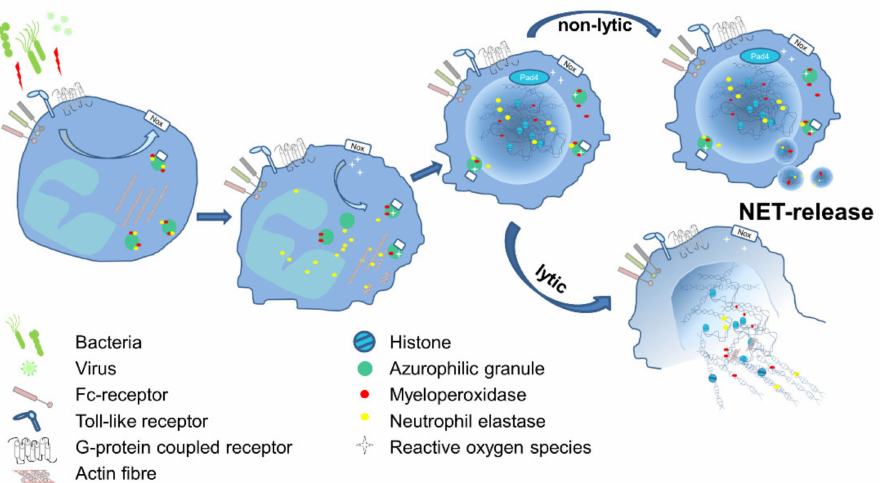
Figure 1. Schematic illustration of the essential steps of NET formation. Several pathogens are capable of inducing NET formation directly or via release of peptides or damage associated molecular patterns (DAMPs). Receptors like TLR, FcR or GPCR transmit signals into the cell and activate predominantly the NADPH-oxidase complex (NOX), which subsequently catalyzes production of reactive oxygen species (ROS). In azurophilic granules, NE gets released from the membranes in a ROS-dependent manner and translocates into the nucleus and in parallel degrades actin. NE activity results in the decondensation of chromatin, which is further supported by the PAD4-dependent citrullination of histones. The chromatin, decorated with microbicidal molecules like histones, MPO and NE, is released in the environment. This occurs either in a non-lytic procedure, where DNA fibers are suggested to be released via vesicles, or in a lytic process, followed by the breakdown of the nuclear envelope and the cell membrane, ending with cell